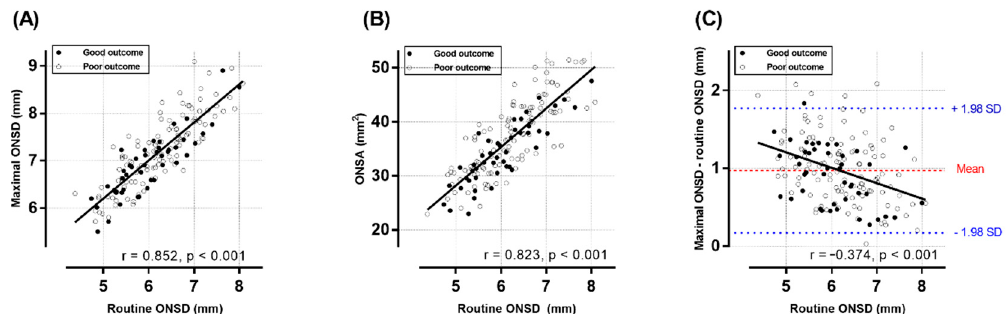
Figure 2. The correlation between the routine ONSD on 4 mm-slice CT images and the maximal ONSD or ONSA on 0.6 mm-slice CT images. The scatter plot and linear regression lines show the correlation between the routine ONSD and maximal ONSD ( A ) or the ONSA ( B ). The difference between the measurements (maximal ONSD minus routine ONSD) are plotted against the routine ONSD ( C ). If the differences between the 2 measurement techniques are small, the plot should center near zero. The red dashed line depicts the mean of the differences; the blue dotted lines denote the limits of agreement (mean ± 1.96 times of SD). The Pearson correlation coefficients (r) and p values are indicated. ONSD: optic nerve sheath diameter, ONSA: optic nerve sheath area, SD: standard deviation.